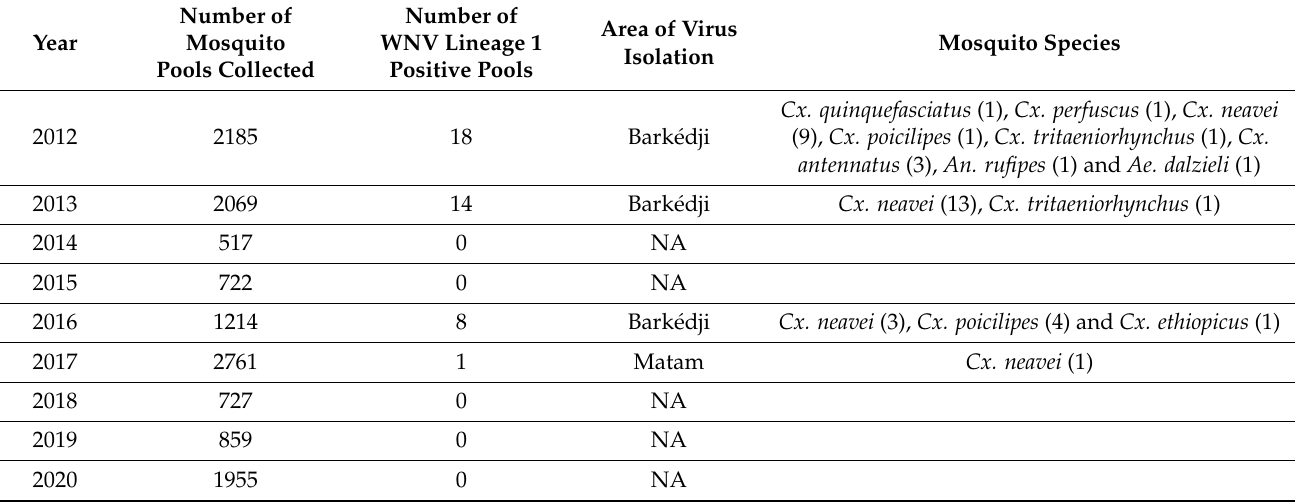
Table 3. The numbers of mosquito pools tested per year as well as the number of WNV positive pools and the species of mosquitoes from which the virus was detected between 2012 to 2020 are listed in this table.